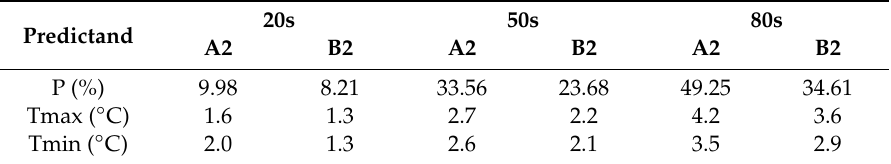
Figure 5. Projected Max and Min Temperatures for the future period until 2100.